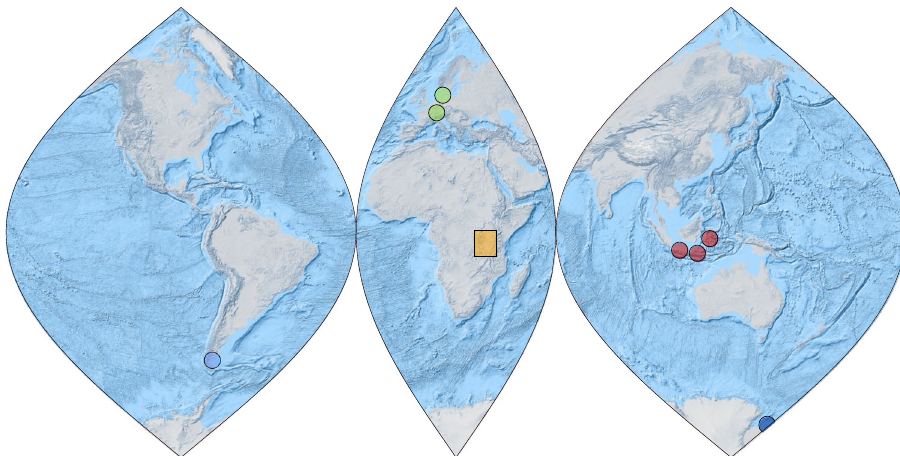
Fig. 1 World map showing the locations of freshwater environments studied for their content of heterocyte glycolipids. Orange square marks the area from which surface sediments of tropical East African lakes have been collected. This includes lakes from the Rwenzori Mountains (Uganda), Mt. Kenya (Republic of Kenya) and East African rift valley lakes that are located on an altitudinal transect from 615 to 4504 masl. Red dots = tropical Lake Towuti (Indonesia), Lake Klakah (Indonesia), and Lake Lading (Indonesia). Green dots = temperate Lake Constance (Germany) and Lake Schreventeich (Germany) 16 . Light blue dot = subpolar Laguna Potrok Aike (Argentina). Dark blue dot = Antarctic meltwater ponds.